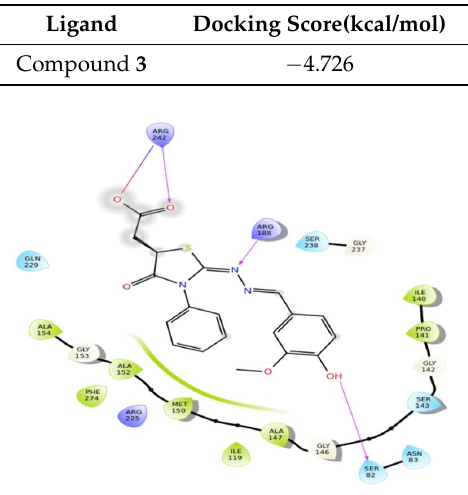
Figure 1. 2D docking pose of ( a ) FAD and ( b ) Compound 2 in the active site of Staphylococcus aureus MurB enzyme. Table 2. Docking score of the compound 3.